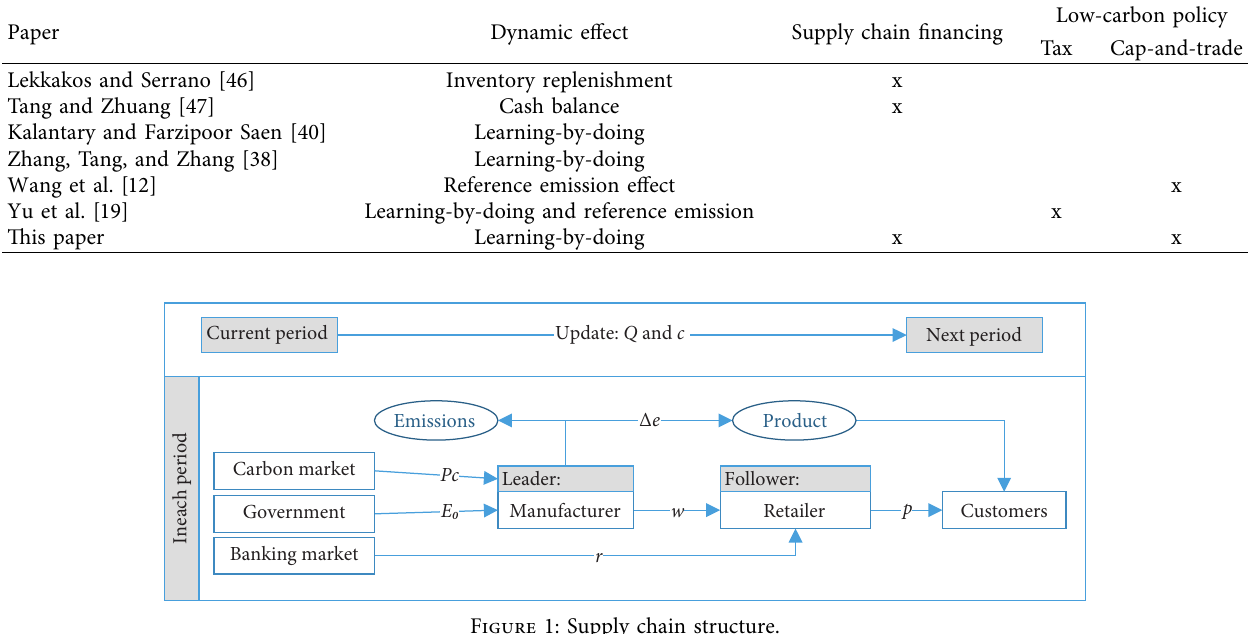
Table 1: Literature comparison regarding low-carbon decision or financing in dynamic supply chains.